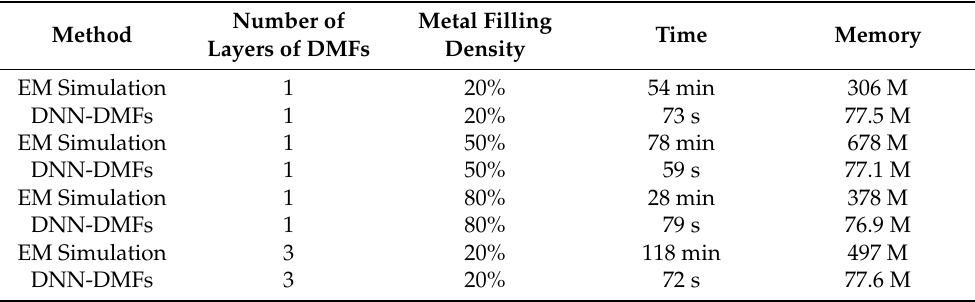
Table 5. Comparison of the efficiency of the EM simulation and the method proposed in this paper.